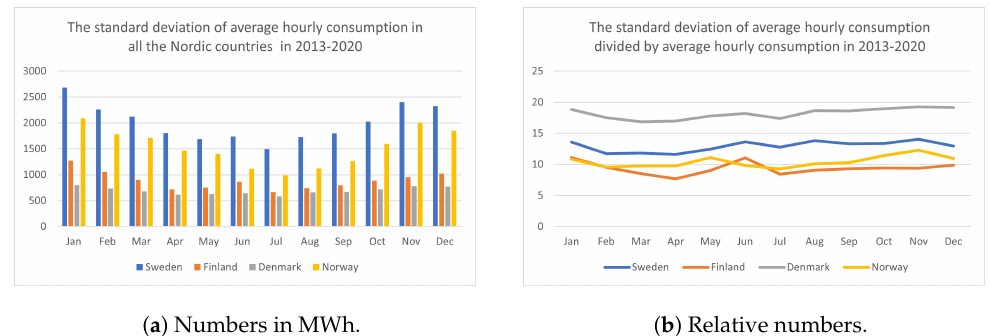
Figure 2. The standard deviation of the average hourly consumption in all the Nordic countries in 2013–2020 ( a ) and the standard deviation of average hourly consumption divided by average hourly consumption in 2013–2020 ( b ).